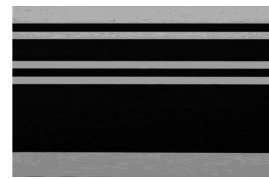
Fig. 3. Scale fragment of a coded leveling staff Fig. 5. Microscope UIM-21, No.